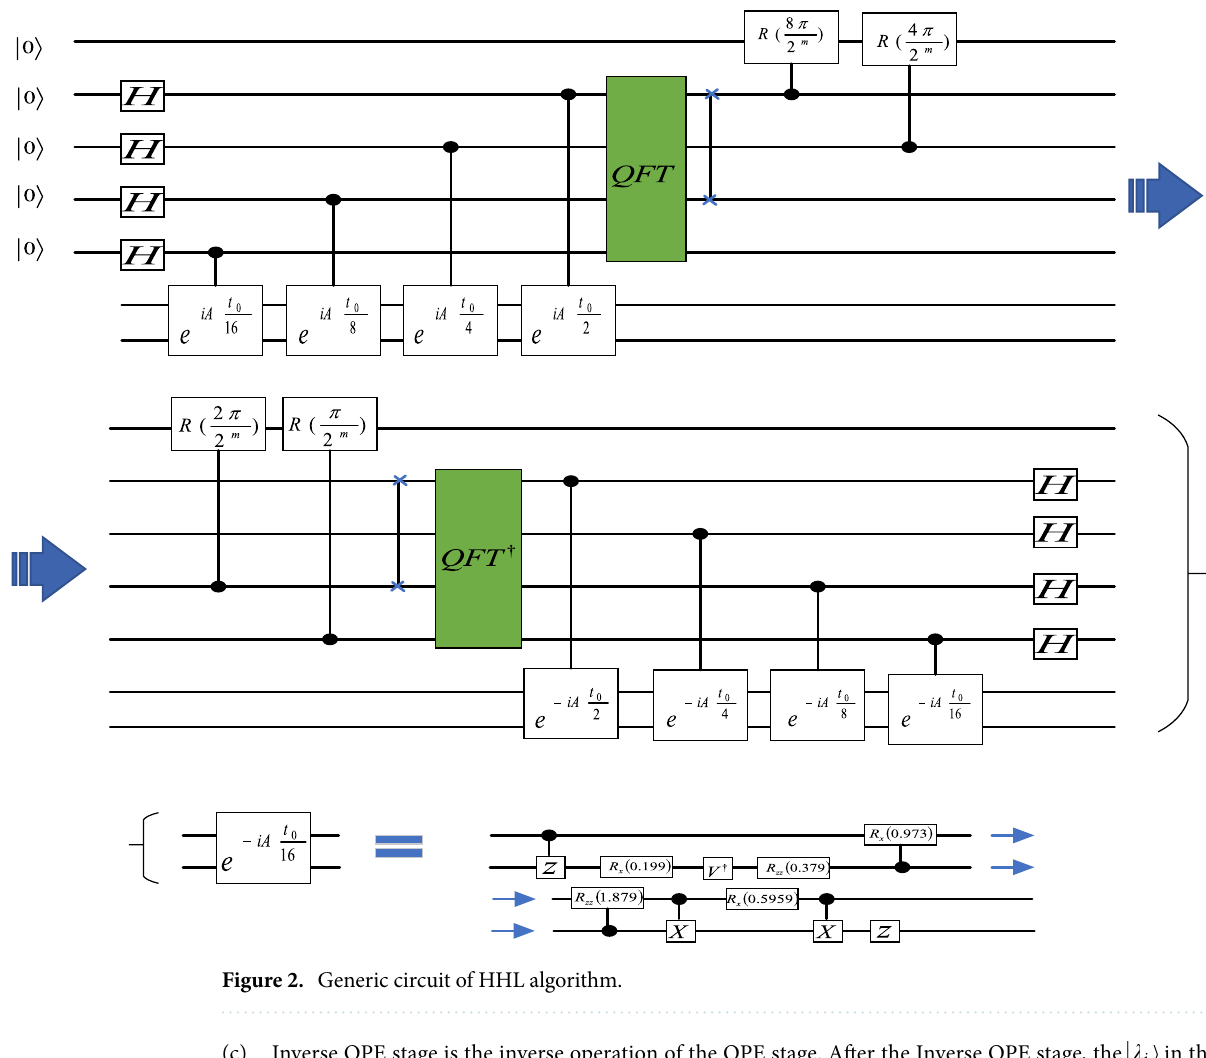
Figure 2. Generic circuit of HHL